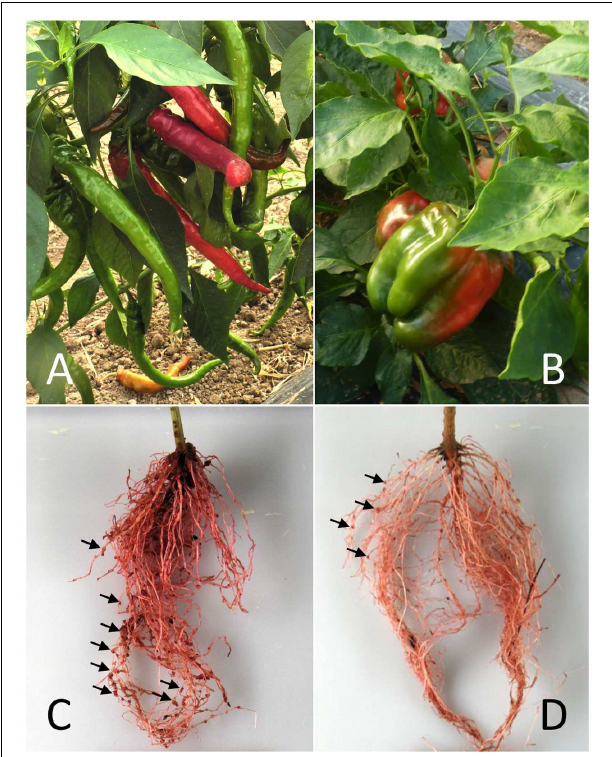
FIGURE 1 | The pepper/ Meloidogyne incognita pathosystem used in this study. The susceptible and resistant pepper cultivars Doux Long des Landes (DLL) (A) and Yolo Wonder (YW) (B) and their respective root systems (C,D) 6 weeks after inoculation with the nematodes. Egg masses (EMs; arrows) were stained with cold eosin